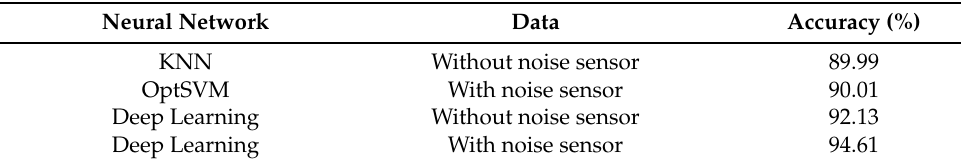
Table 6. Accuracy for learning classical and DL type